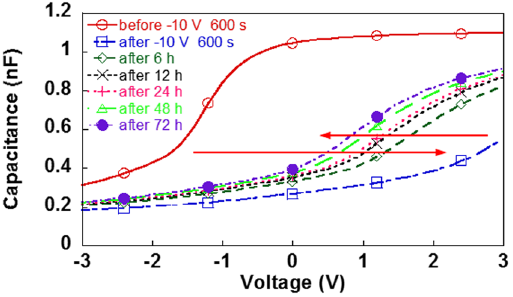
Figure 3. C - V retention characteristics for the capacitor of ZEP520a containing PCBM after writing at − 10.0 V for 600 s. Arrows indicate the directions in which C - V curves shifted. Solid lines are for before applying the gate voltage, and dashed and dash-dotted lines are for after applying the gate voltage.